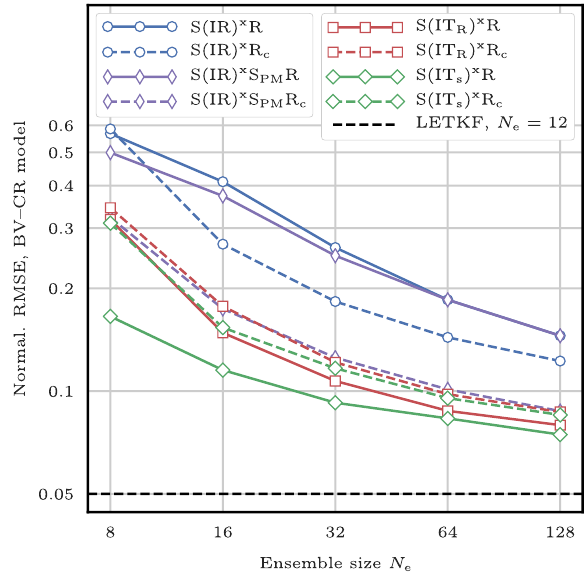
Figure 18. RMSE as a function of the ensemble size N e for the LPF x s. The scores are displayed in units of the observation standard deviation σ